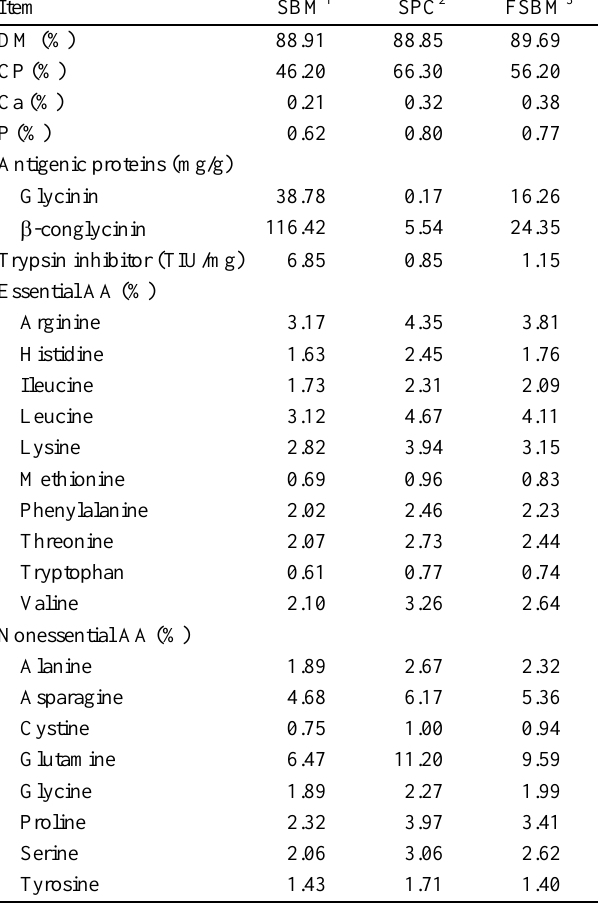
Table 1. Analyzed nutrient composition and antigenic proteins of soybean meal (SBM), soy protein oncentrate (SPC) and fermented soybean meal (FSBM) (as-fed basis)